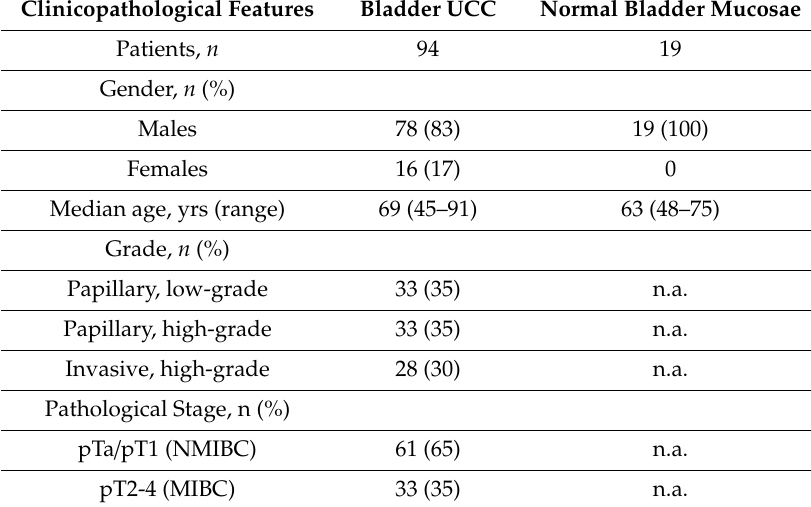
Table 1. Clinical and histopathological parameters of Bladder Cancer patients, and gender and age distribution of control set